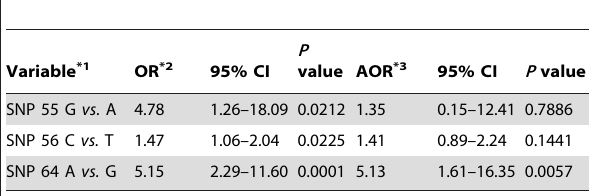
Table 4. The OR and AOR for the 3 SNPs selected by backward logistic